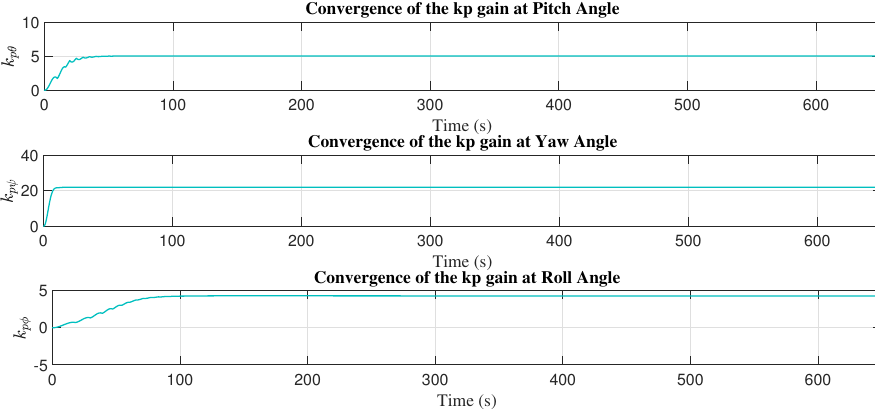
Figure 25. Convergence ˆ k p with MIT rule with high order sliding modes